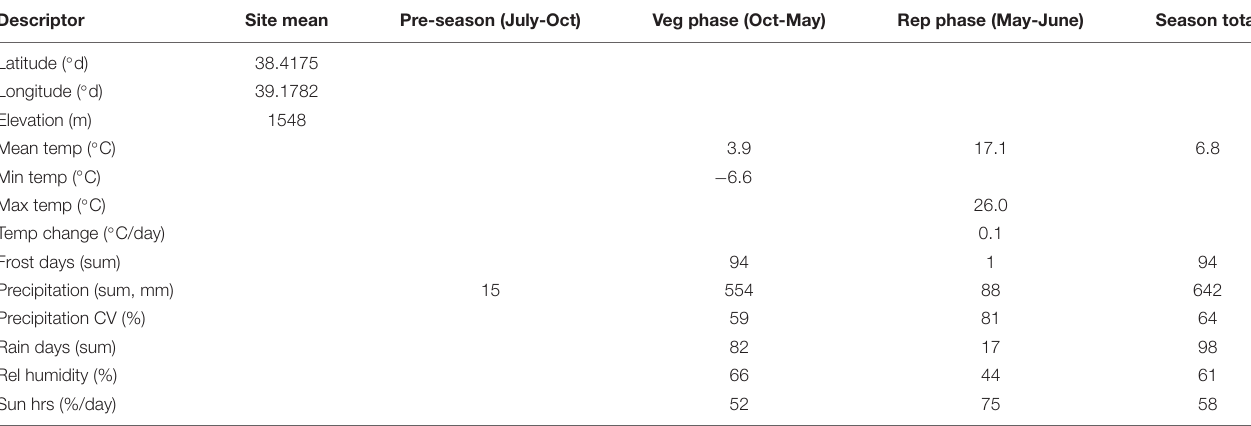
TABLE 4 | Characteristics of the sole C. turcicum collection site at Yedipinar village, Sivrice district, Elazig province, Turkey based on geographic data extracted from Garmin Montana 650 and climate data from WorldClim (Hijmans et al., 2005) and 10 min Climatology (New et al., 2002), calculated over the indicated growing season